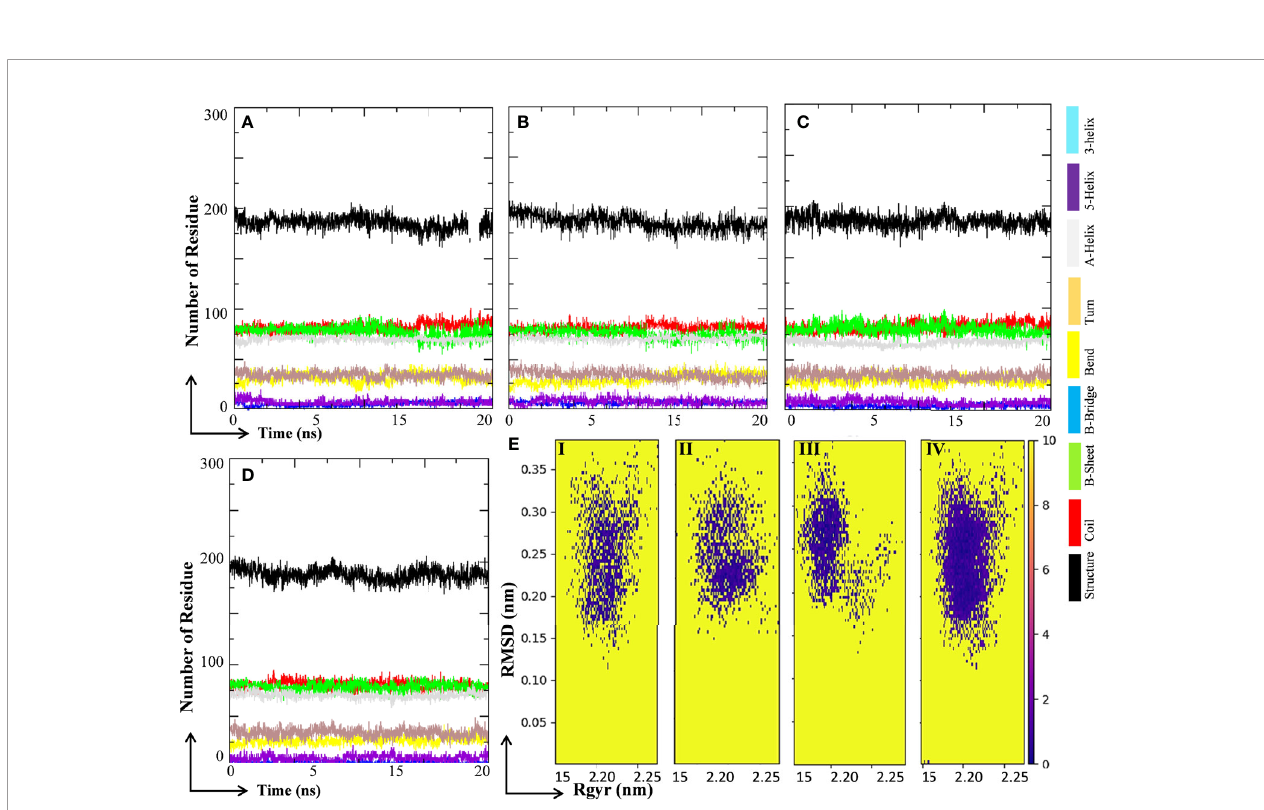
FIGURE 9 | Secondary structure change and protein-ligand energy landscape of SARS-CoV-2 Main protease unbound and ligand-bound conformation. The secondary structure changes during the 20 ns MD simulation in (A) Unbound M pro protein, (B) Lopinavir-bound M pro complex, (C) Aloe vera lead compound 10- Hydroxyaloin A – bound M pro complex, and (D) Neem lead compound Isoquercetin-bound M pro complex. The free energy landscape of the (Ei) Unbound M pro protein, (Eii) Lopinavir-bound M pro complex, (Eiii) Aloe vera lead compound – bound M pro complex, and (Eiv) Neem lead compound – bound M pro